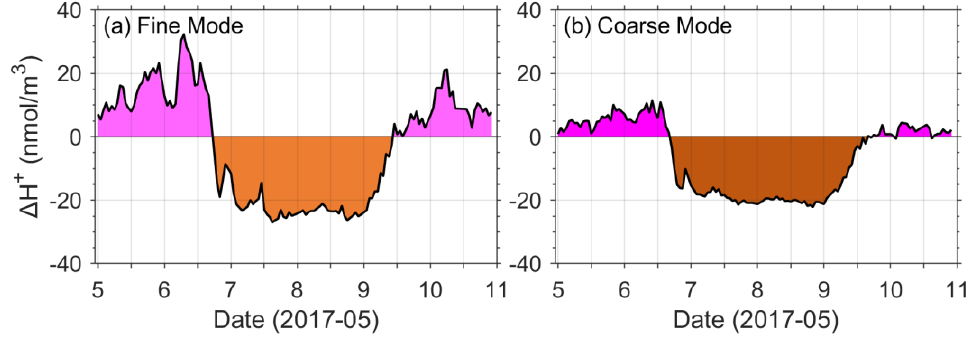
Figure 5. Aerosol chemical speciation analyzer (ACSA)-observed ΔH + of ( a ) fine and ( b ) coarse aerosol.